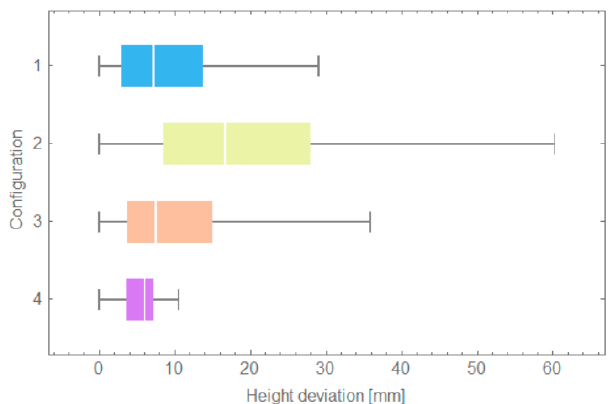
Figure 7. The second configuration has been the worst condition while configuration 1, 3, and 4, despite being characterized by the same median, are deeply different.